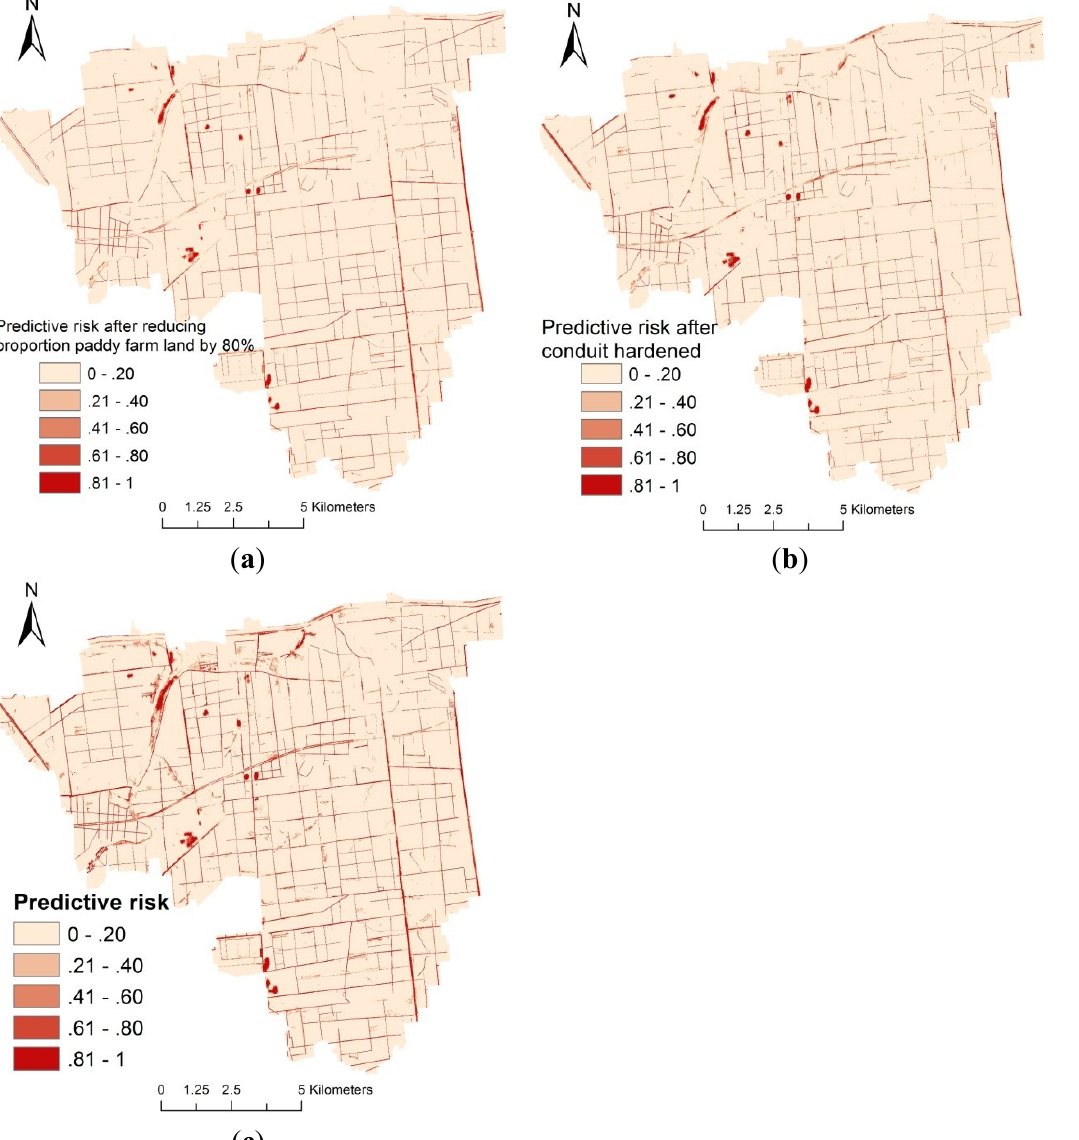
Figure 3. Map-simulated effects of paddy farming land rotationto dry farming land ( a ) and conduit hardening ( b ) compared with the risk before the implementation of these two environmental control strategies ( c ) in Haokou, Qianjiang